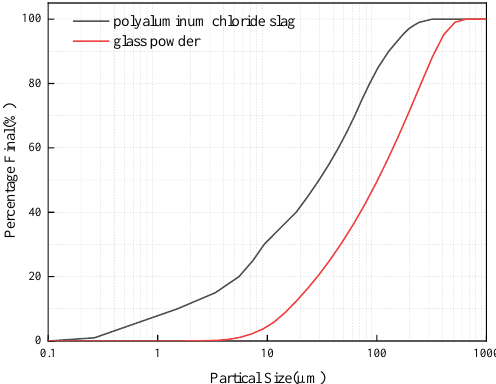
Figure 2. Particle size distribution curve of polyaluminum chloride slag and glass powder.